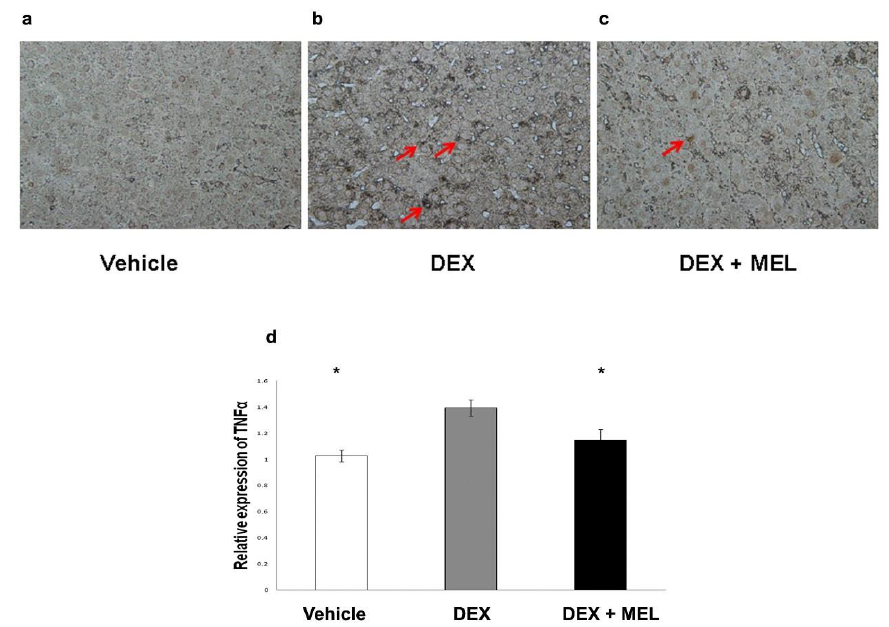
Figure 6. The TNF- α immunohistochemistry showed ( a – c ) increased staining in the prenatal steroid compared with the control group and decreased in the melatonin group (original magnification ×400, red arrows: positive hepatocytes). ( d ) Semi-quantification of the TNF- α immunohistochemistry staining. All the results represent the mean ± standard error of six animals; * p < 0.05 when comparing with DEX group. The letters above each represented different groups with DEX representing the prenatal dexamethasone; DEX+MEL, melatonin treatment after prenatal dexamethasone.